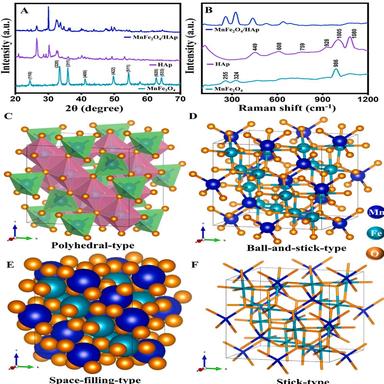
(A) XRD analysis and (B) Raman spectra for prepared MnFe2O4, HAp, and MnFe2O4/HAp ceramic materials. Crystal structures of MnFe2O4 (C) Polyhedraltype, (D) Ball-and-stick-type, (E) Space-filling-type, and (F) Stick-type of MnFe2O4.